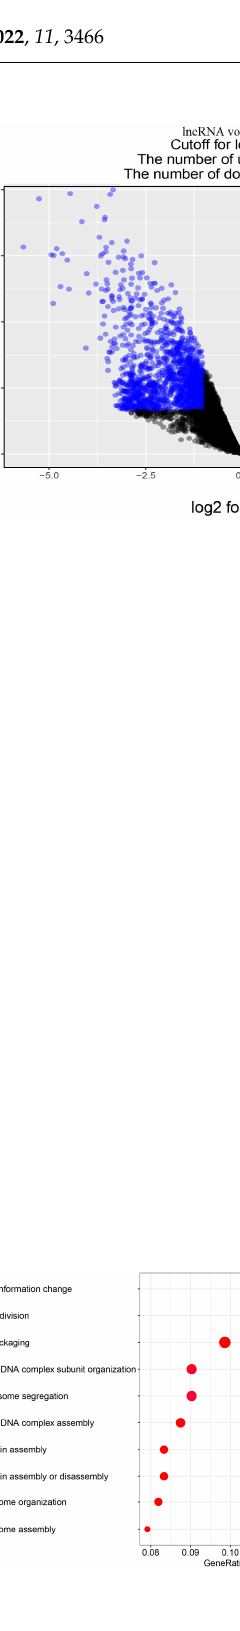
Figure 4. Gene Ontology enrichment analysis of downregulated mRNA between hepatocellular car- cinoma and para-carcinoma tissues: ( A ) biological process, ( B ) cell component, ( C ) molecular func- tion. Figure 5. Top pathways associated with upregulated and downregulated pathways of mRNAs. 3.4. Validation of lncRNA MAGI2-AS3/miR374-5p/FOXO1 Axis from HCC ceRNA Network QRT-PCR was applied to validate the ceRNA network of Figure 1B, and the result is shown in Figure 6. We found that miR-374a/b-5p had a high expression in HCC tissue ( p